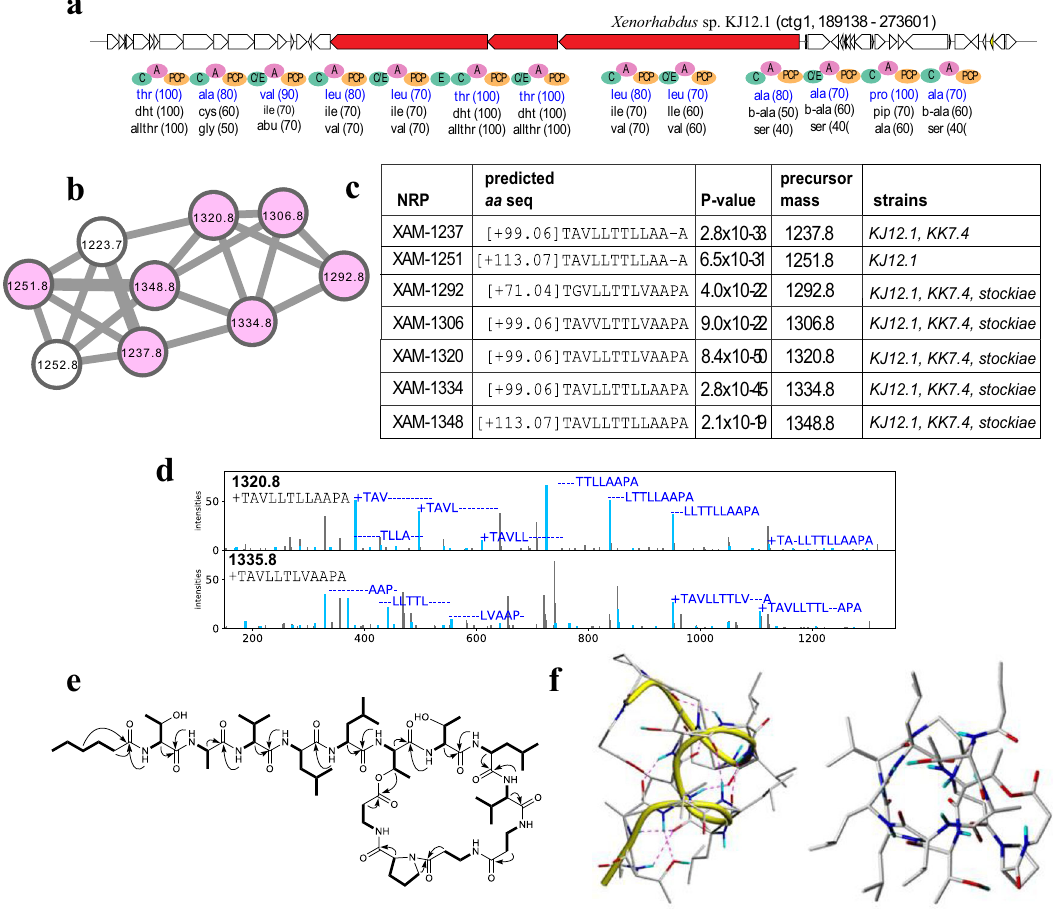
Fig. 5 Identifying xenoamicin-like (XAM) NRP family. a The BGCs generating the NRP in Xenorhabdus sp. KJ12 along with NRPS genes (shown in red) and A-, C-, PCP-, and E-domains in these NRPSs. The rest of the genes in the corresponding contigs are shown in white. Three highest-scoring amino acids for each A-domain in these BGCs (according to NRPSpredictor2 (ref. 15 ) predictions) are shown below the corresponding A-domains. Amino acids appearing in the NRP [ + 99.06]TAVLLTTLLAAPA identi fi ed by NRPminer (with the lowest p value) are shown in blue. b Spectral network formed by the spectra that originate from NRPs in the XAM family. c Sequences of the identi fi ed NRPs in this family (with the lowest p value among all spectra originating from the same NRP). The p values are computed based on MCMC approach using MS-DPR 89 with 10,000 simulations. d For each strain, an annotated spectrum representing the lowest p value is shown. The spectra were annotated based on predicted NRPs [ + 99.06]TAVLLTTLLAAPA and [ + 99.06] TAVLLTTLVAAPA from top to bottom. The “ + ” sign represents the addition of [ + 99.06]. Supplementary Figures 23 and S24 show the annotated spectra for the other NRPs shown in part ( c ). e NMR-based correlations of XAM-1320 ( m / z 1320.8 [M + H] + ) produced by Xenorhabdus KJ12.1 (Supplementary Table 5 and Supplementary Figs. 25 – 29). HSQC-TOCSY (bold lines) and key ROESY correlations (arrows) are shown. f 3D structure of XAM-1320 derived from 121 ROE-derived distance constraints (Supplementary Table 6), molecular dynamics, and energy minimization. Peptide backbone is visualized with a yellow bar (left). Predicted hydrogen bonds stabilizing the β -helix are shown as dashed lines. View from above at the pore formed by XAM-1320